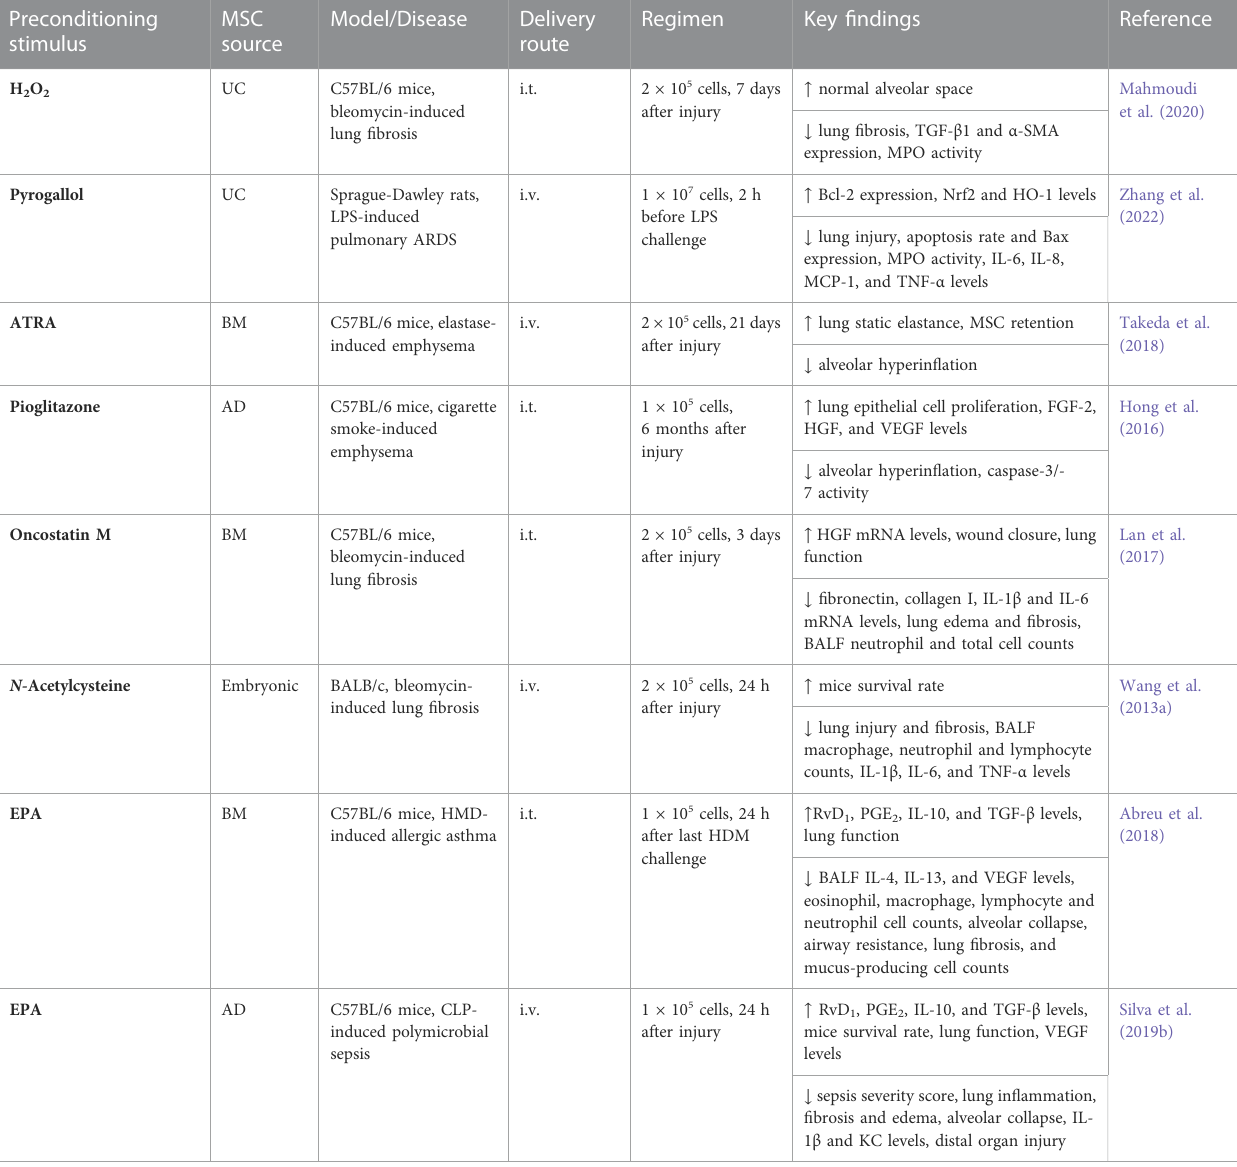
TABLE 3 In vivo preclinical studies assessing the ef fi cacy of MSC preconditioning with pharmacological agents or other